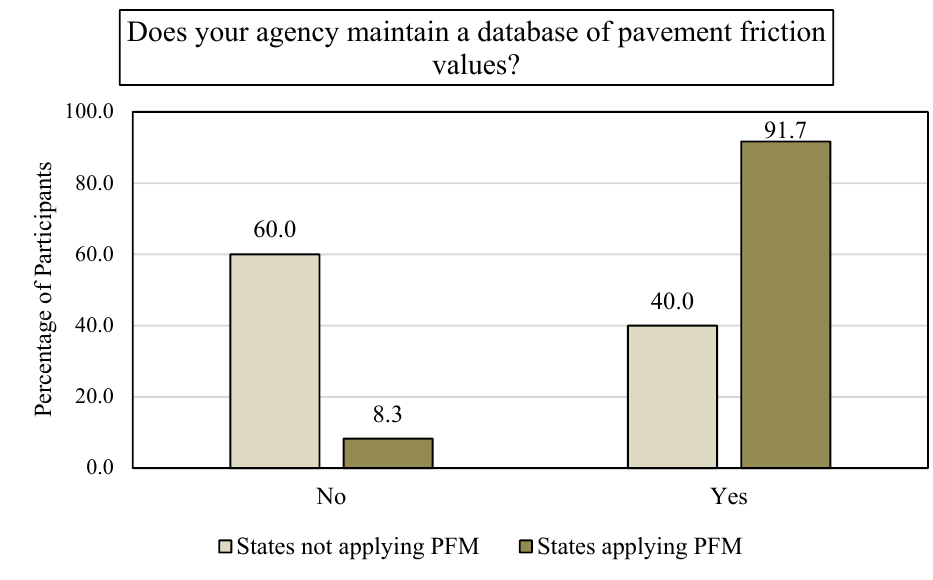
Figure 12. State DOT practices of pavement friction treatments on rigid pavement.